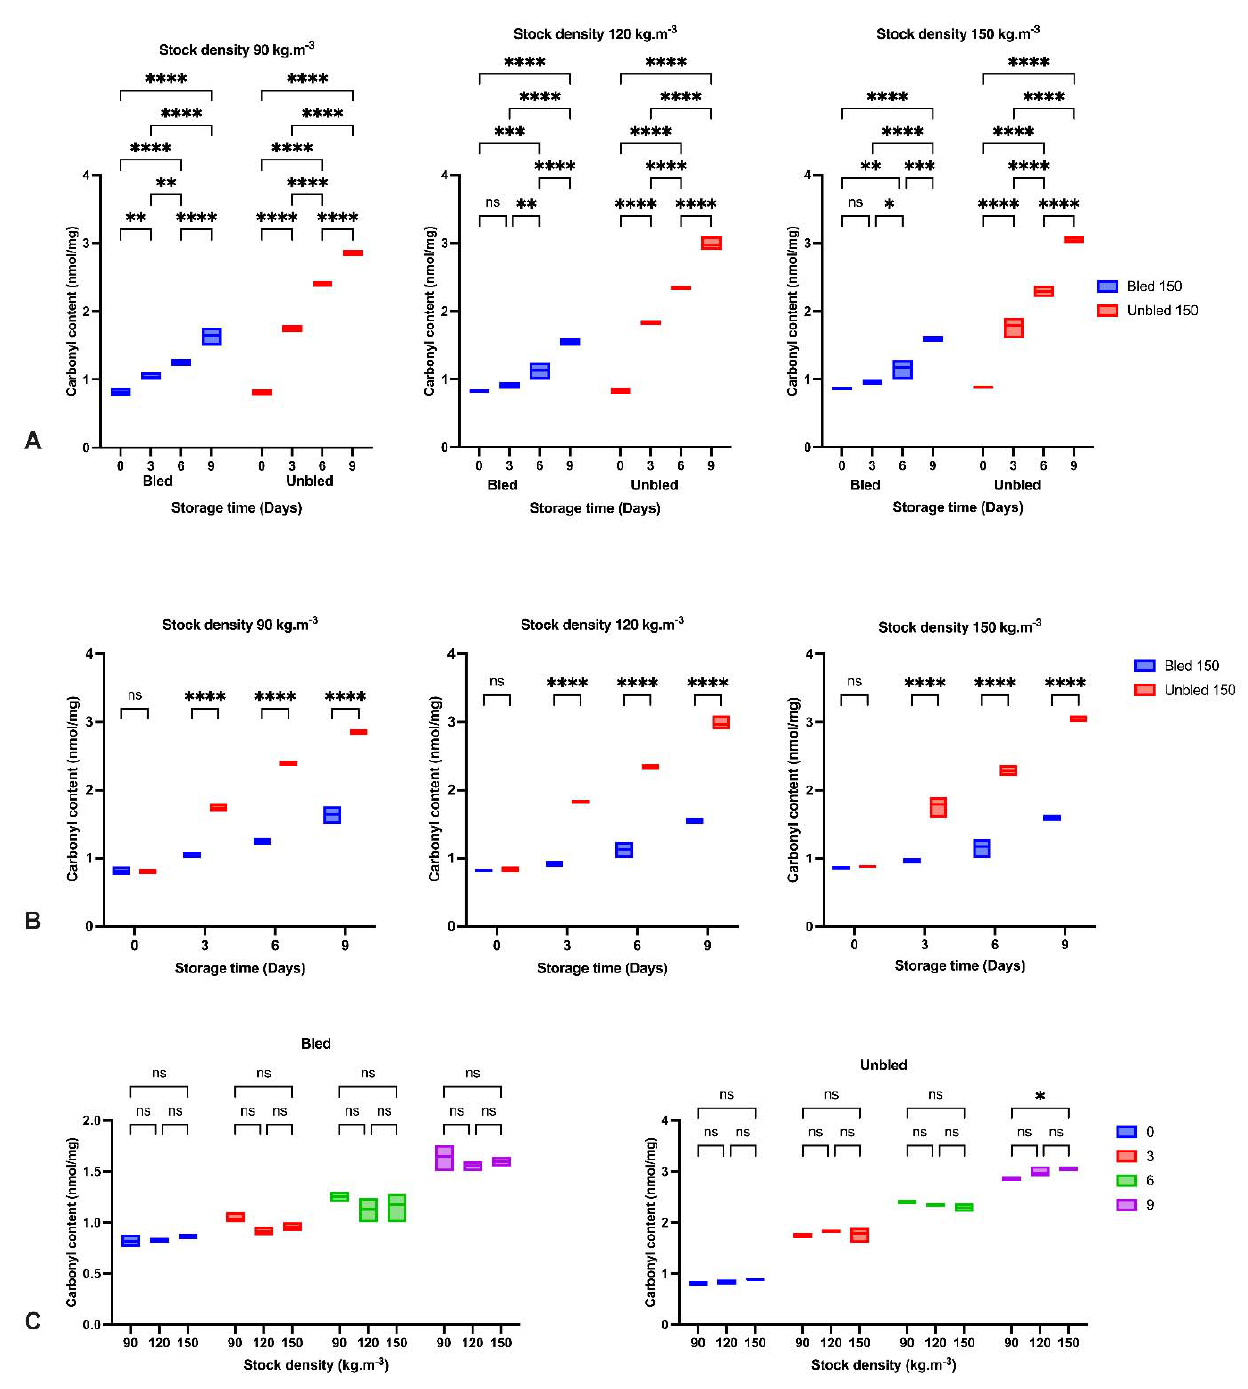
Figure 6. Carbonyl content: ( A ) During the storage time (0, 3, 6 and 9 days) in bled and unbled groups at different stock densities (90, 120 and 150 kg · m − 3 ); ( B ) In bled and unbled groups at each storage time (0, 3, 6 and 9 days) and at different stock densities (90, 120 and 150 kg · m − 3 ); ( C ) In different stocking densities (90, 120 and 150 kg · m − 3 ) during storage time (0, 3, 6 and 9 days) in bled and unbled groups; ( p < 0.05, Tukey’s multiple comparisons test; ns: non-significant; * p < 0.05; ** p < 0.01; *** p < 0.001; **** p < 0.0001). Box plots showing the line at upper quartile, lower quartile and at the mean. The amount of MDA and protein content increased almost three times (240%) and two times (110%), respectively, in unbled fillets after 3 days of storage; however, bled